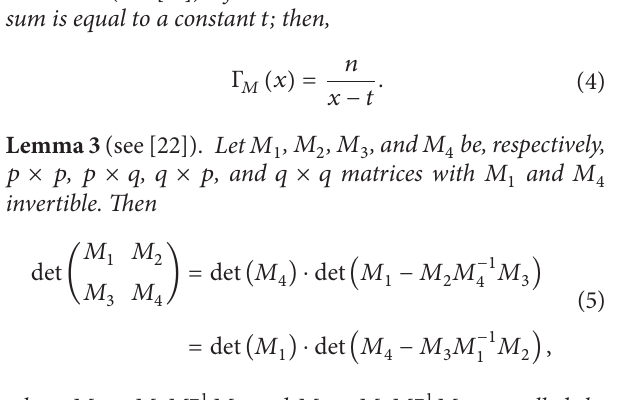
Figure 1: An example of subdivision-vertex-vertex join and subdivi- sion-edge-edge join